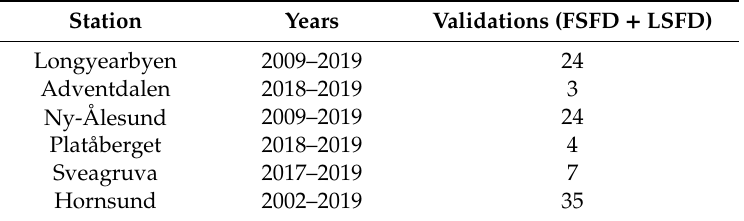
Table 1. Meteorological stations, observation periods and years with first / last day of snow validations. The total number of validations (i.e., sum of first snow-free day (FSFD) and last snow-free day (LSFD)) is given in the third column. Note that many years were lost due to unstable snow